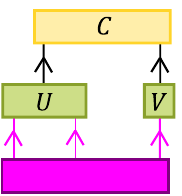
FIG. 20. Entanglement detection through hybrid GPTs. Purple lines indicate quantum systems; black lines, boxes. Starting from a quantum state, we effect two transformations U , V to map it to a bipartite box, which we then probe with the normalized CHSH